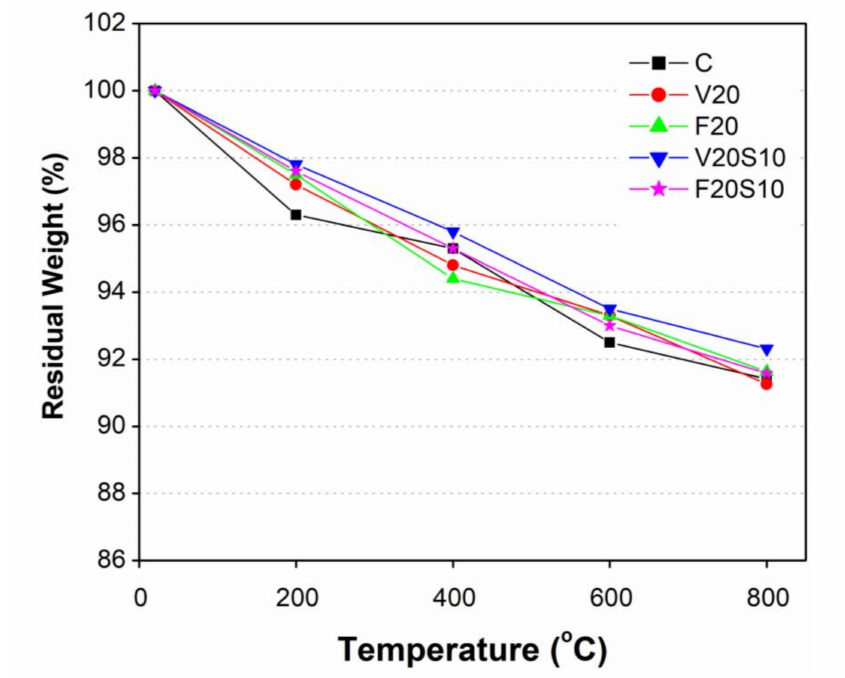
Figure 5. Residual weight of concrete specimens after exposure to different elevated